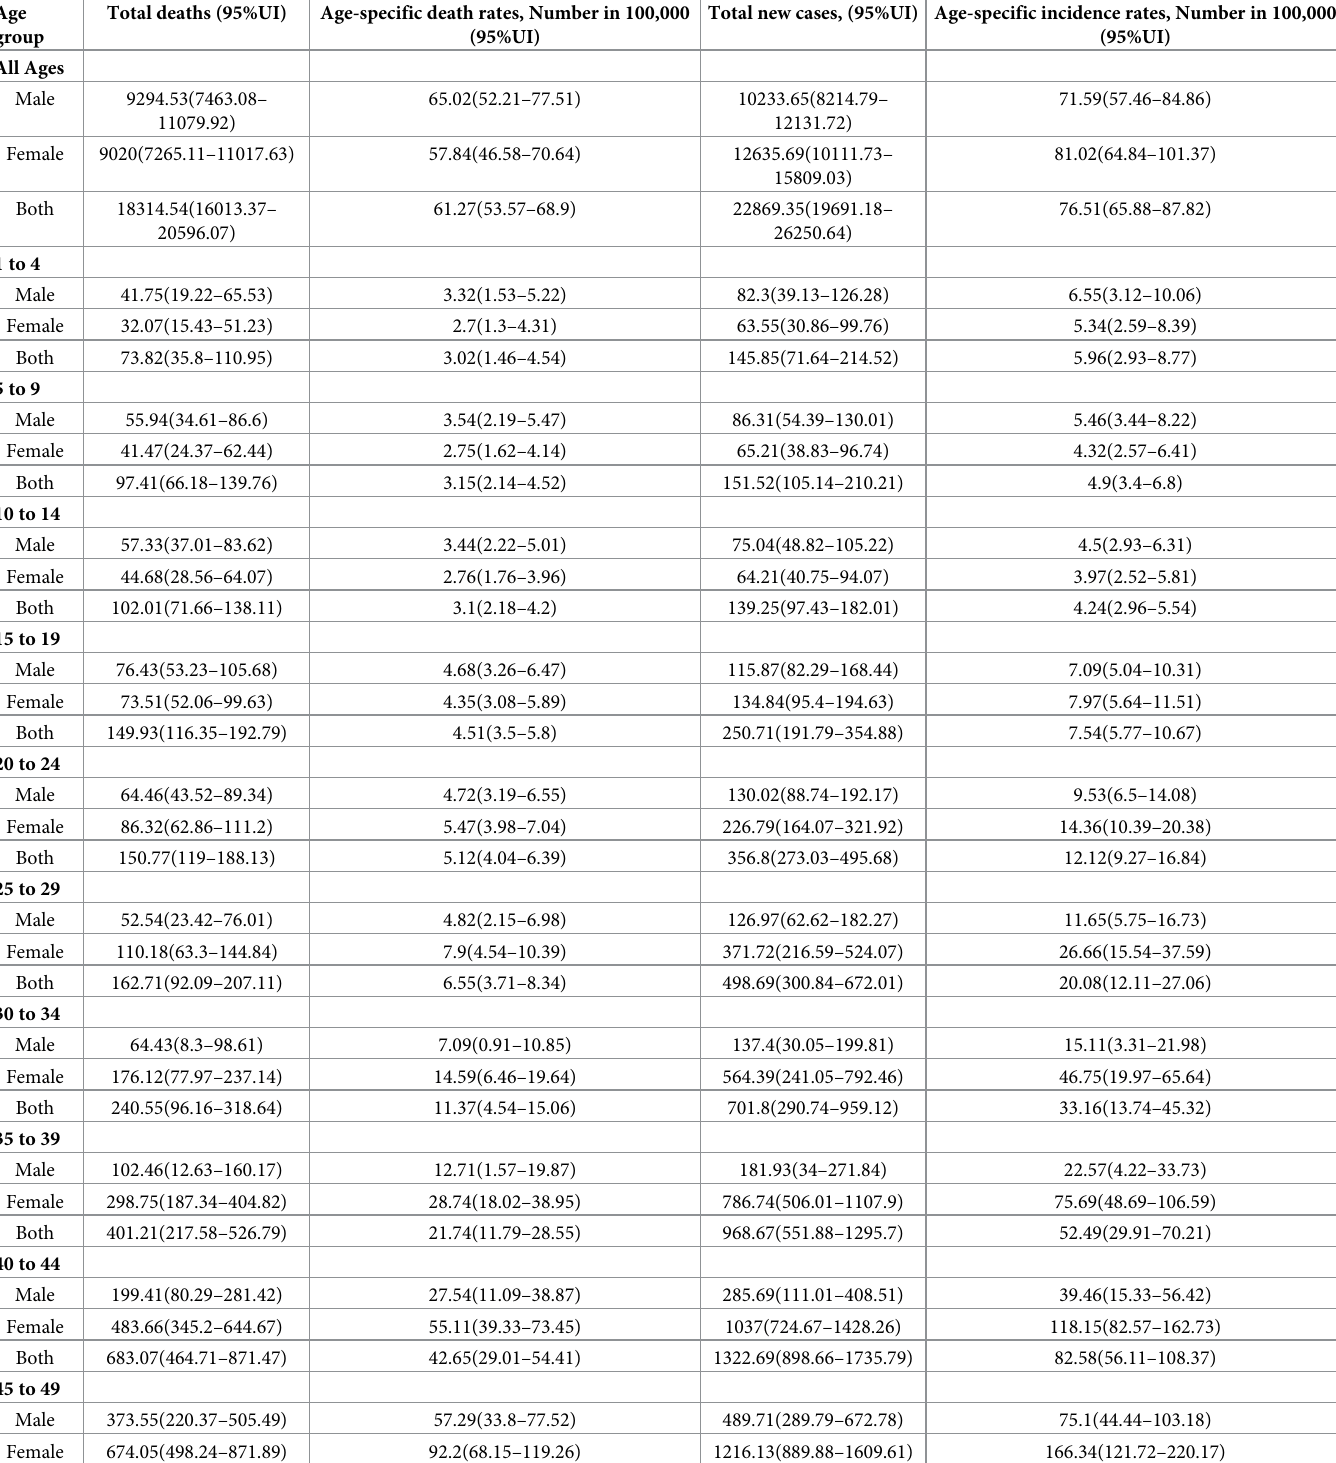
Table 2. Age-specific number of new cancer cases, deaths, incidence rate and mortality rates of cancer by gender in Nepal, 2017. Age